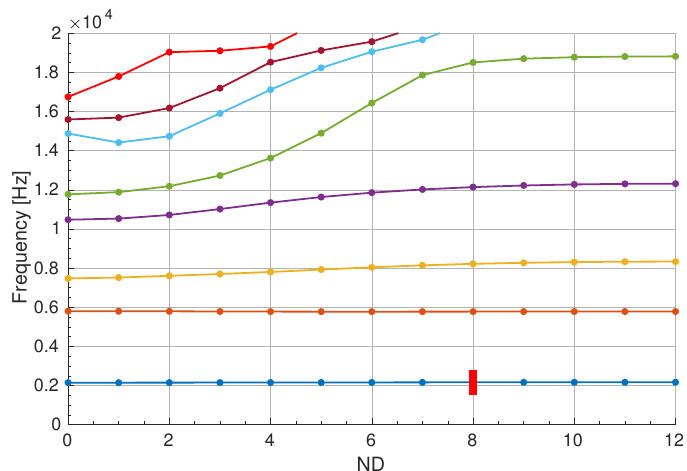
Figure 3. Rotor A natural vibration frequencies. Red thick line indicates the forcing case considered with engine order EO = 8.